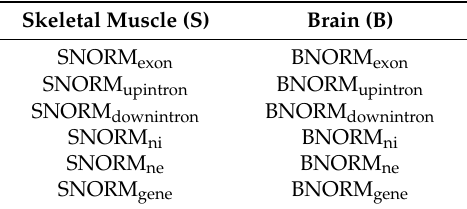
Table 9. The description of the normalized features.